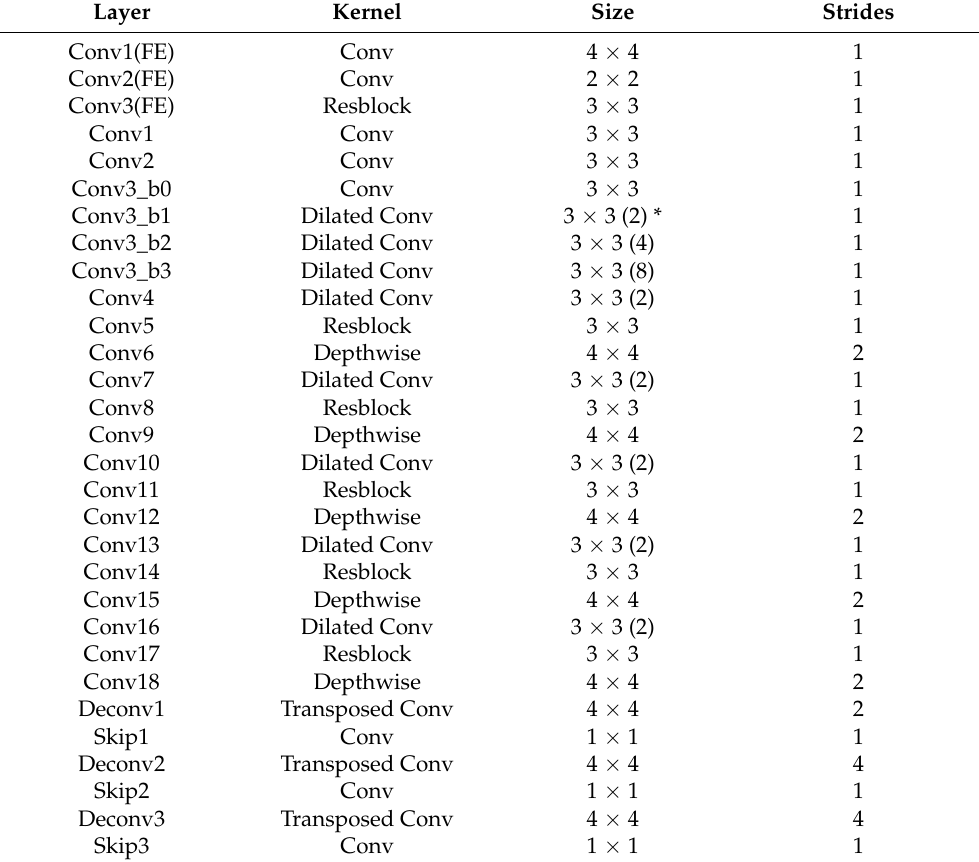
Figure 5. Structure of feature extraction module and data input/output segments: ( a ) feature extraction module; ( b ) data input segment; ( c ) data output segment. Table 1. Detailed parameters of neural network